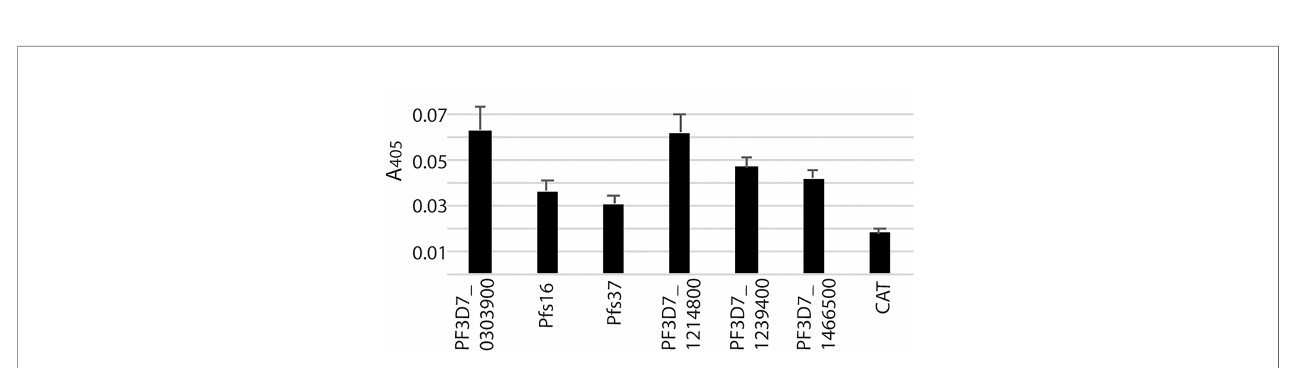
FIGURE 4 | The interaction between the candidate proteins and unhomogenized mosquito